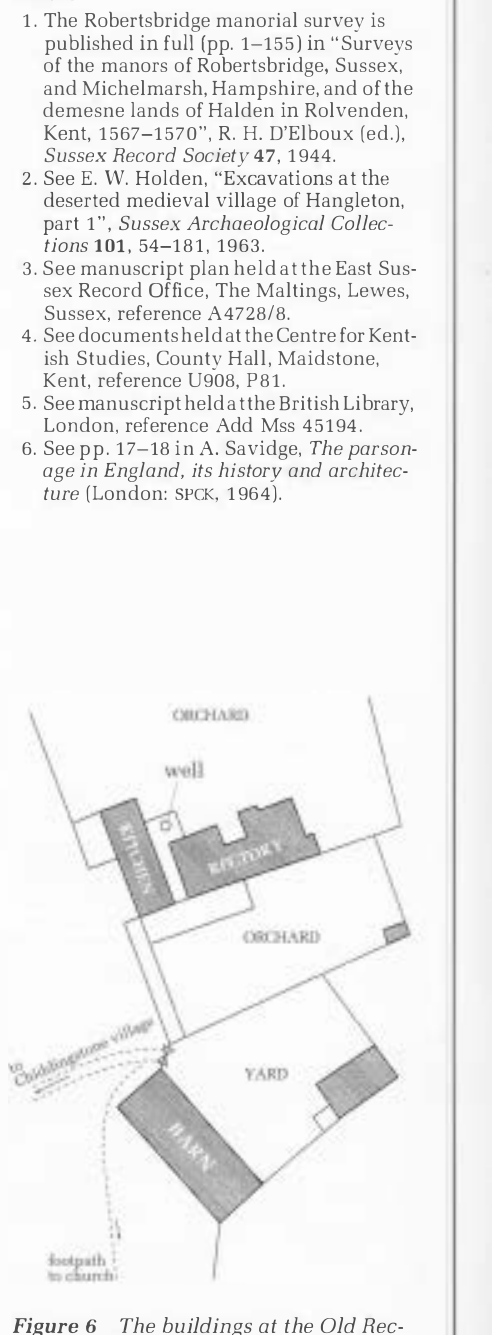
tory, Chiddingstone, Kent, in 1 706 show­ ing the relationship of the kitchen (which was approximately 15m (49 feet) long) to the house; based upon a plan held at the Centre for Kentish Studies (seen. 4}, refer­ ence U909,